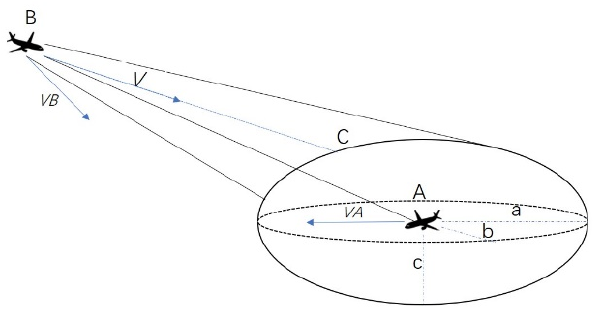
Figure 3. Schematic diagram of speed obstacle model.